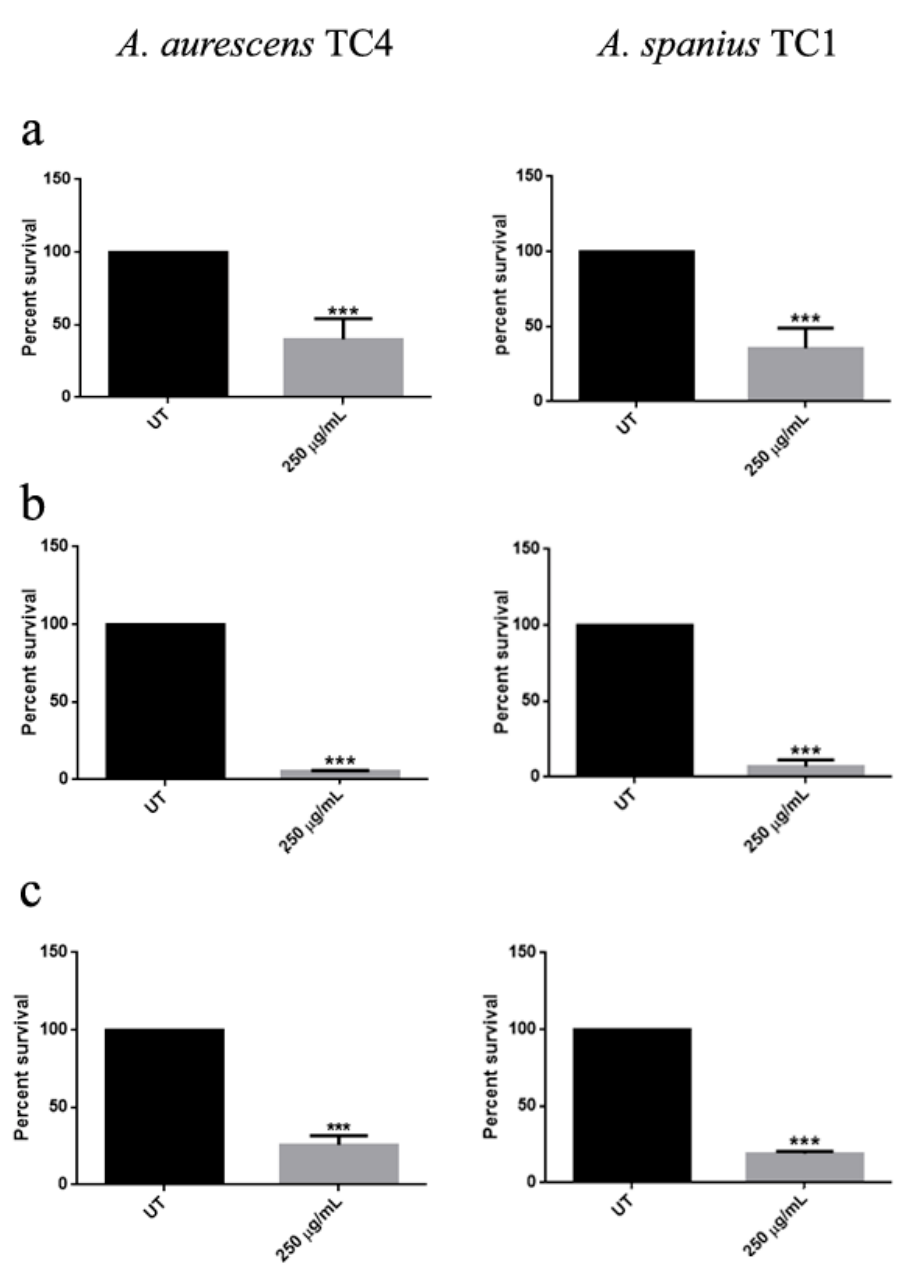
Figure 6. Cell viability after treatment of stone specimens with ZNGs. CFU counting of the indicated species after 24 h of incubation on treated stones. ( a – c ) indicate respectively Noto stone, common yellow brick, and Carrara marble. To assess statistical analysis a one-way ANOVA analysis with the Bonferroni post-test was used (*** p < 0.001 with respect to UT).